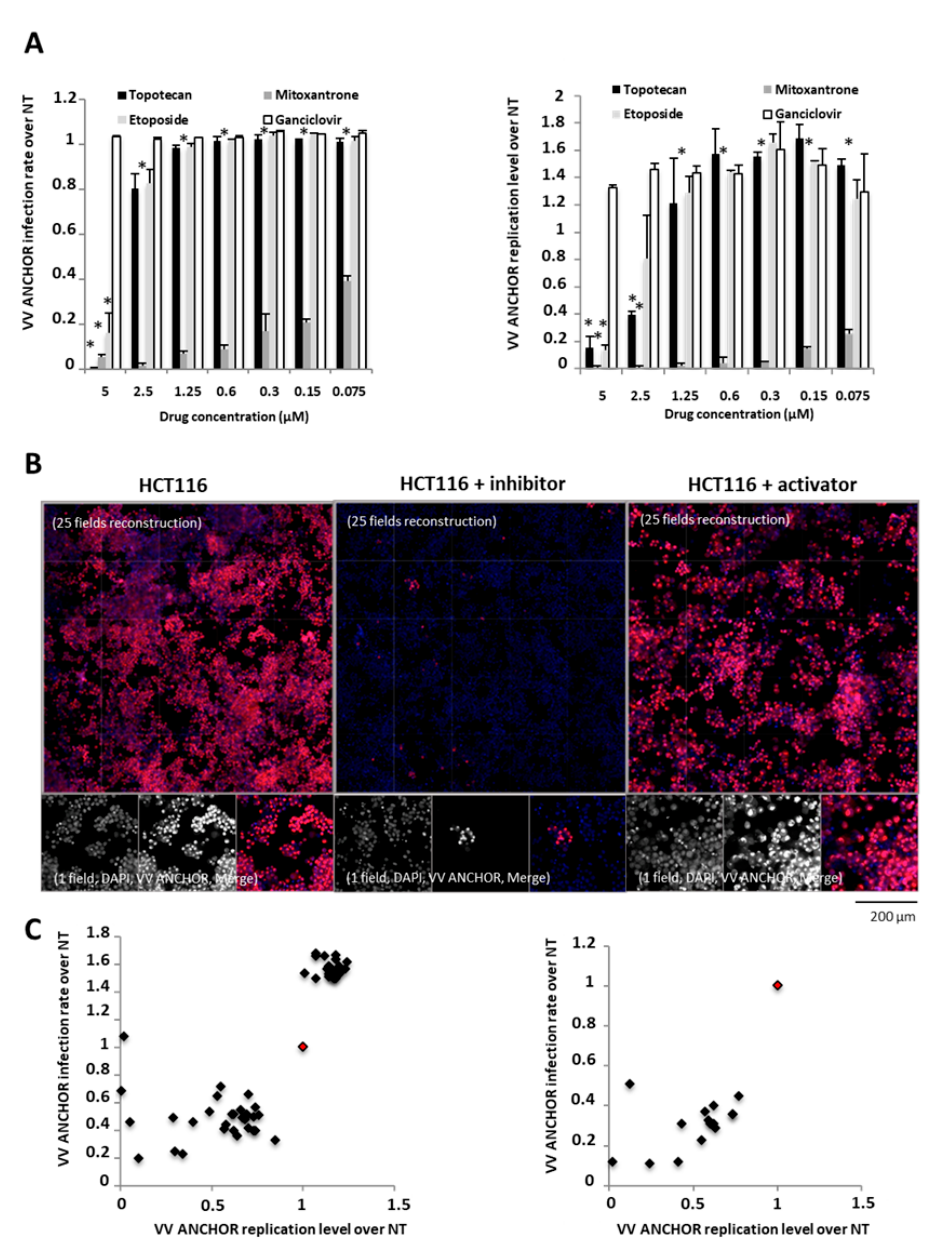
Figure 6. VACV ANCHOR responds to the anticancer treatment and allows fast and e ffi cient discovery ofnewoncolyticmodulators. ( A )HeLacellsweretreatedwiththeindicatedconcentrationofcompounds and immediately infected with VACV ANCHOR at an MOI of 0.25. Cells were fixed and processed for HCI 48 h post-infection. Results are expressed as fold increased between treated and non-treated cells (NT). Values are average of 3 independent wells ± SD. * p < 0.05 compared to infected cells without drug treatment. ( B ) HCT 116 cell line was used in a high-content screening campaign to identify potential inhibitor or activator of VACV ANCHOR oncolytic capacities. Cells were plated at 1 × 10 5 cells / well. The day after, cells were treated with 1.25 µ M of test compounds and immediately infected with the virus at a MOI of 0.05. Seventy-two hours post-infection, cells were processed for HCI. Example of signal untreated (left), treated with an inhibitor (middle) or with an activator (right) are displayed, either a 25-field reconstruction of the well or a single field at the bottom. ( C ) Scatter plot of the hits identified at the primary (left) and the secondary (right) screening. Value for each compound passing the threshold is displayed (black dot). The control value without drug treatment is indicated by a red